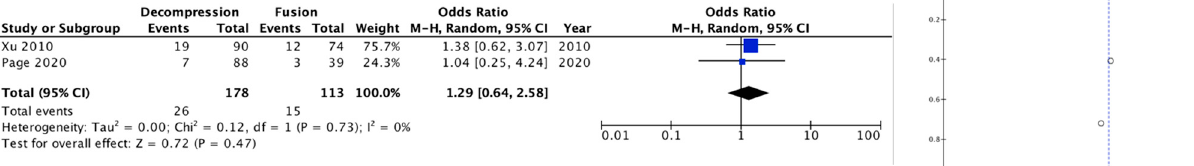
Figure A11. Post-op radiculopathy.